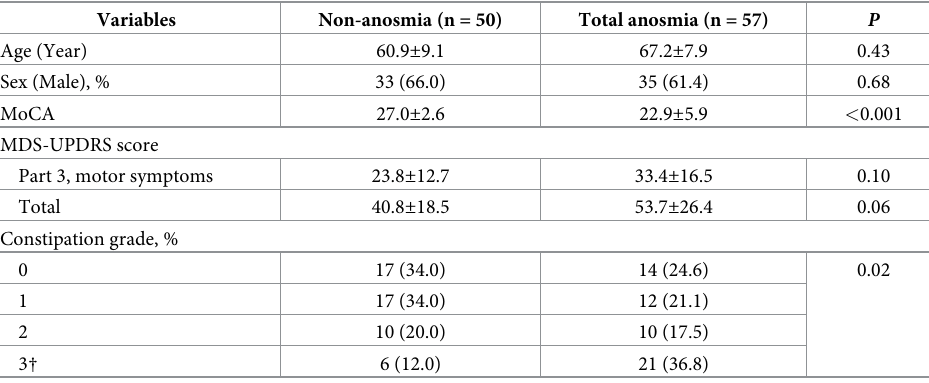
Table 1. Demographic